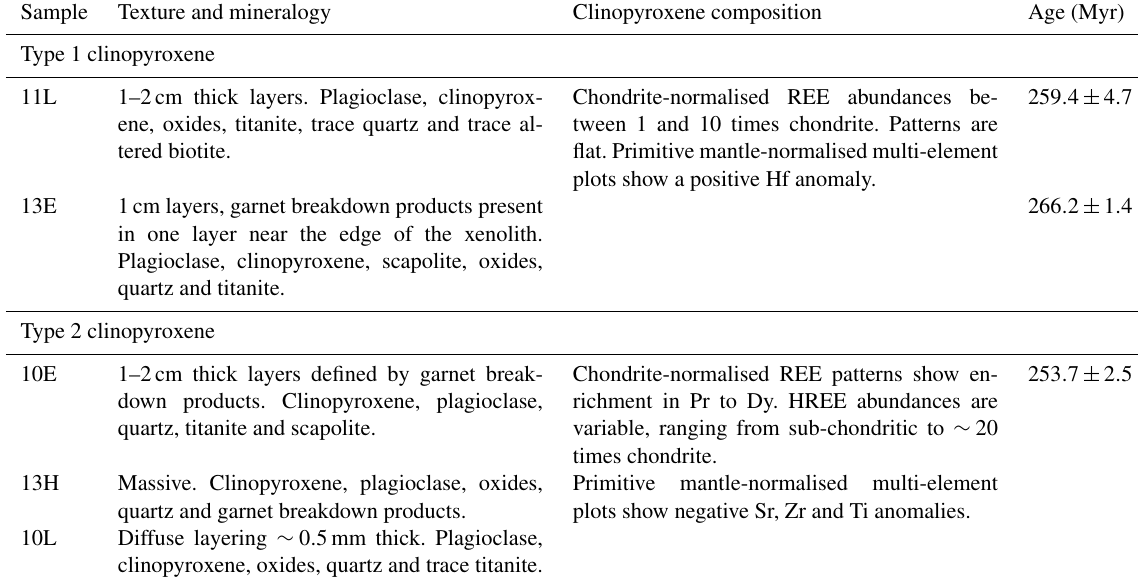
Table 1. Sample description and summary of age data. Sample